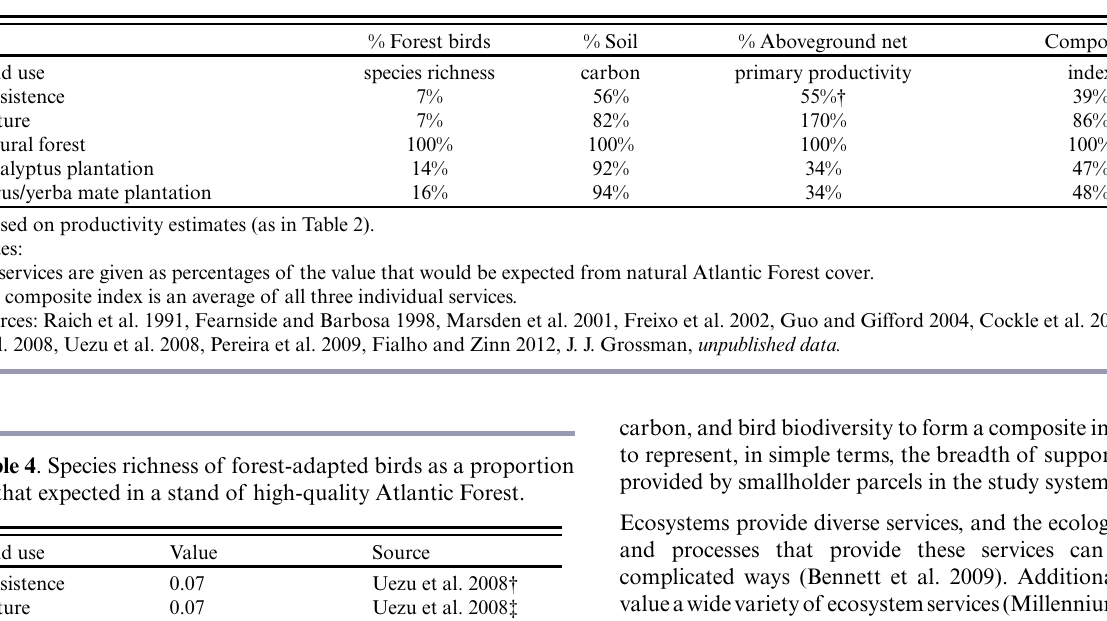
Table 3 . Components of a composite index of supporting ecosystem services.